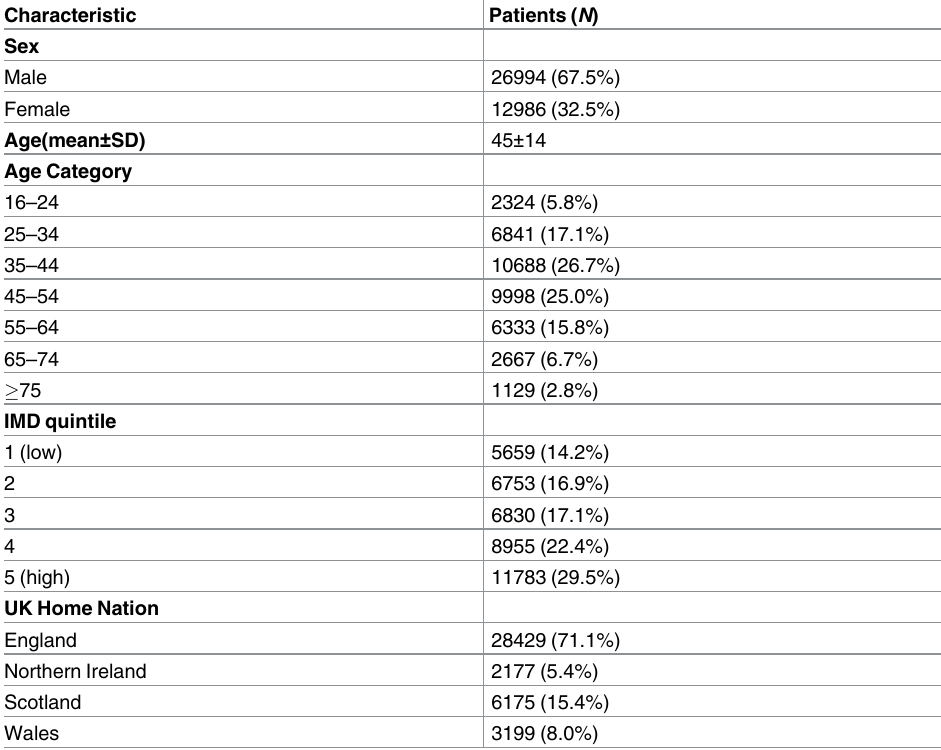
Table 1. Baseline characteristics of